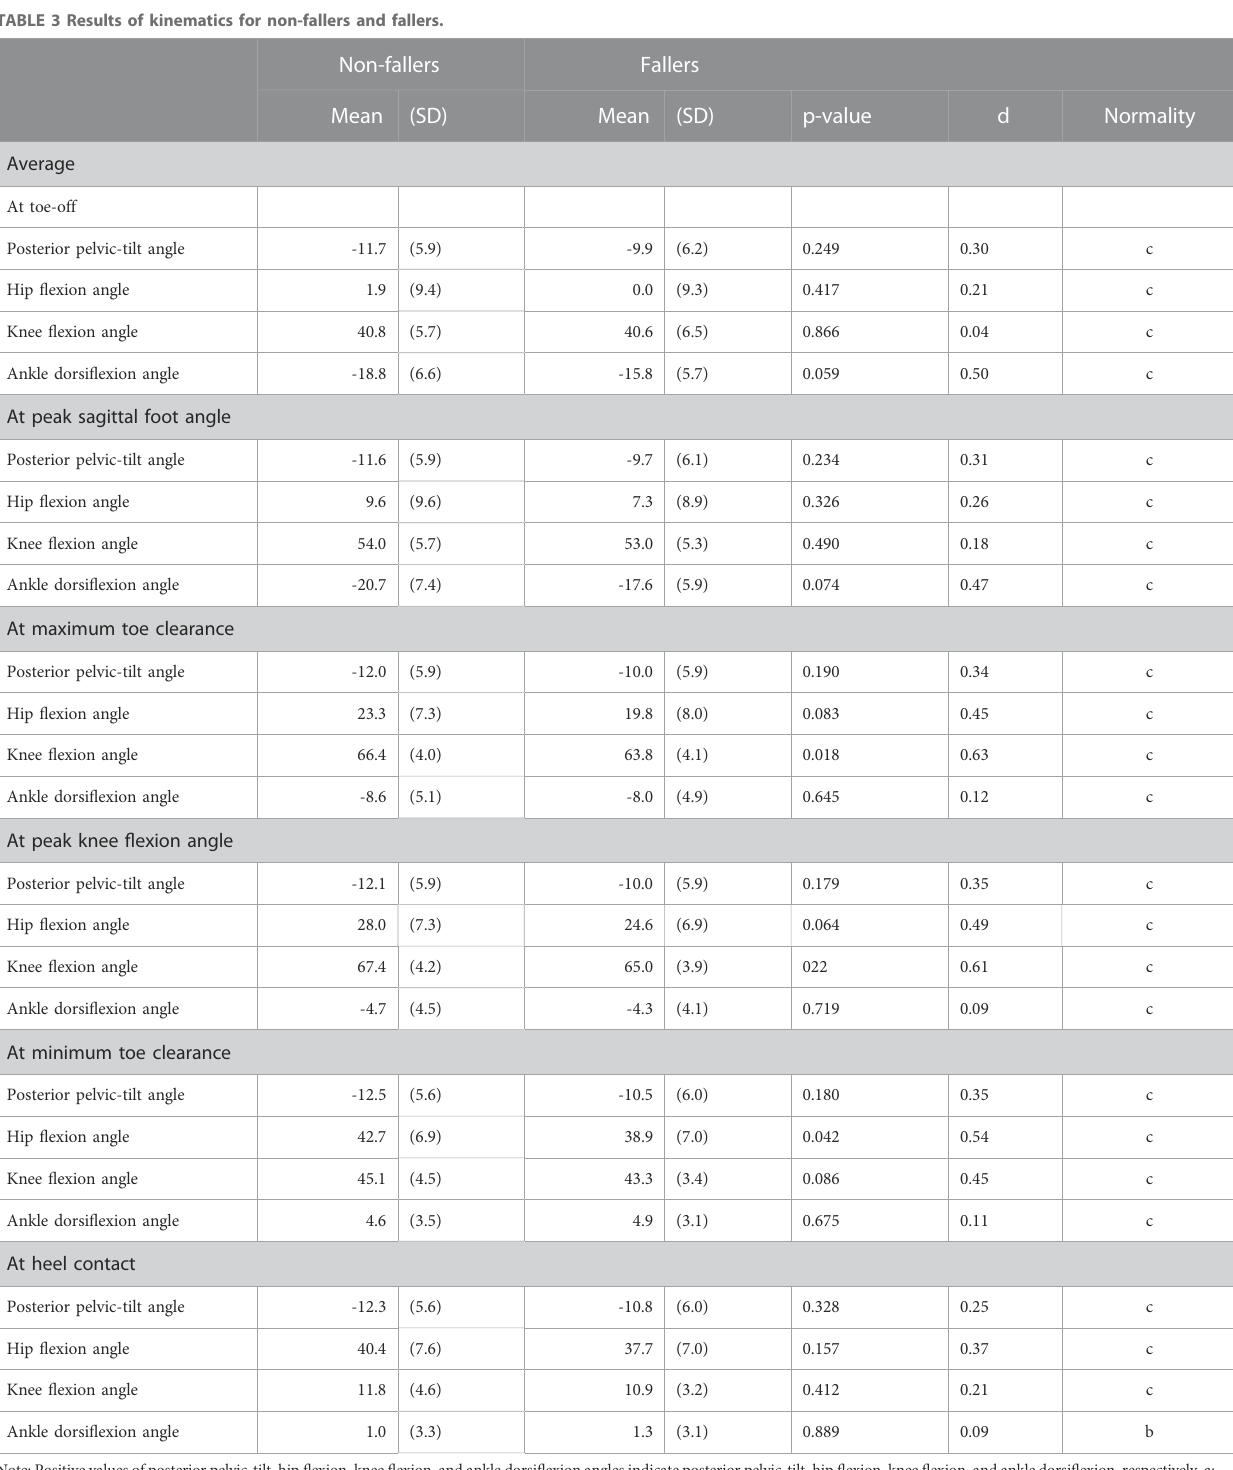
TABLE 3 Results of kinematics for non-fallers and